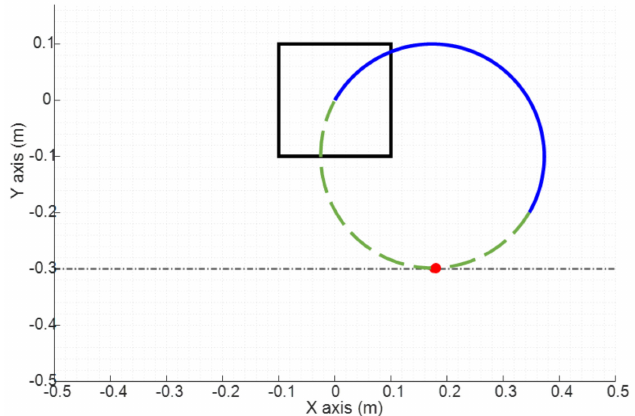
Figure 5. System representation rotated at an angle where the α min solution corresponds to the symmetric semi-circle represented in